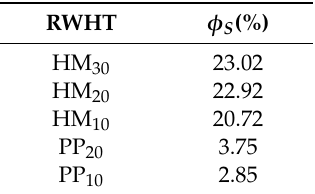
Table 6. Water stress mitigation e ffi